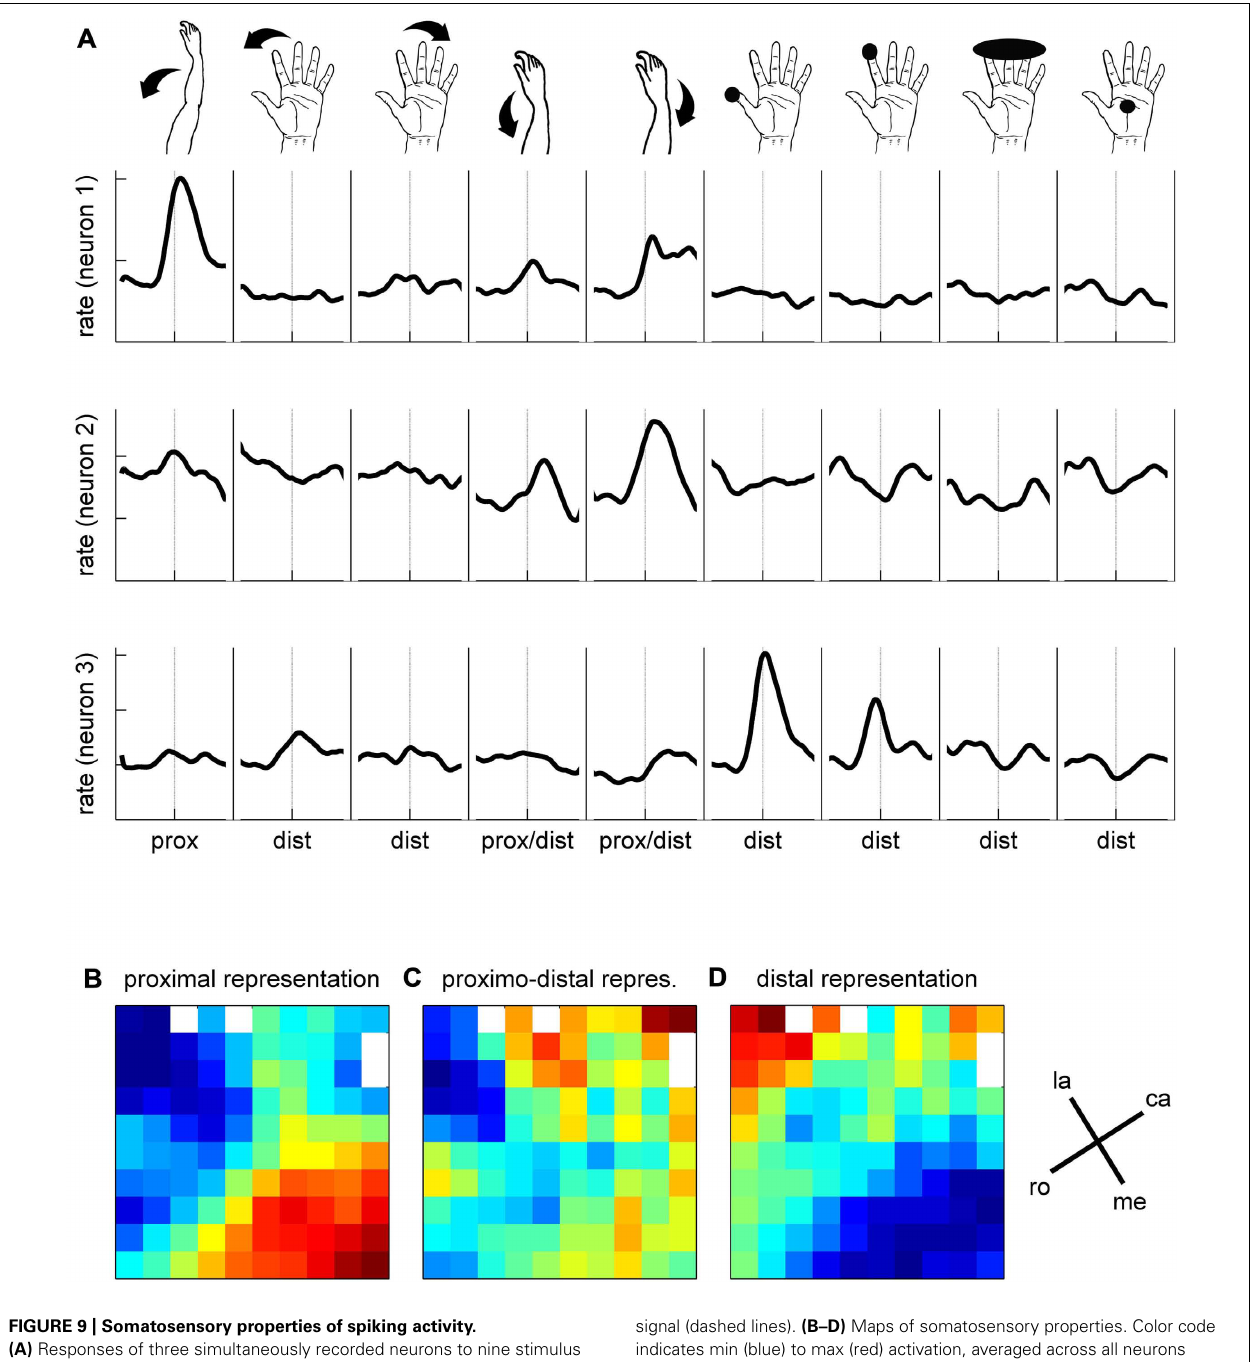
FIGURE 9 | Somatosensory properties of spiking activity. (A) Responses of three simultaneously recorded neurons to nine stimulus conditions, as indicated by the drawings above. Mean firing rates are indicated in z -score, averaged across ∼ 30 trials. For each stimulation condition, the mean firing rate is presented ± 400 ms around the trigger